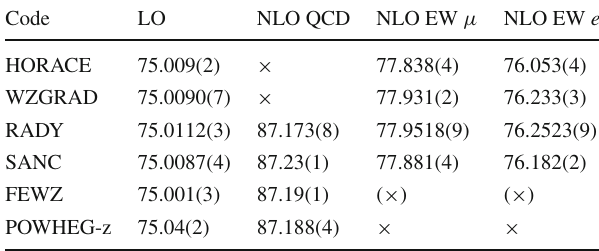
Table 17 pp → γ, Z → l − l + cross sections (in pb) at the 8 TeV LHC, with LHCb cuts and bare leptons